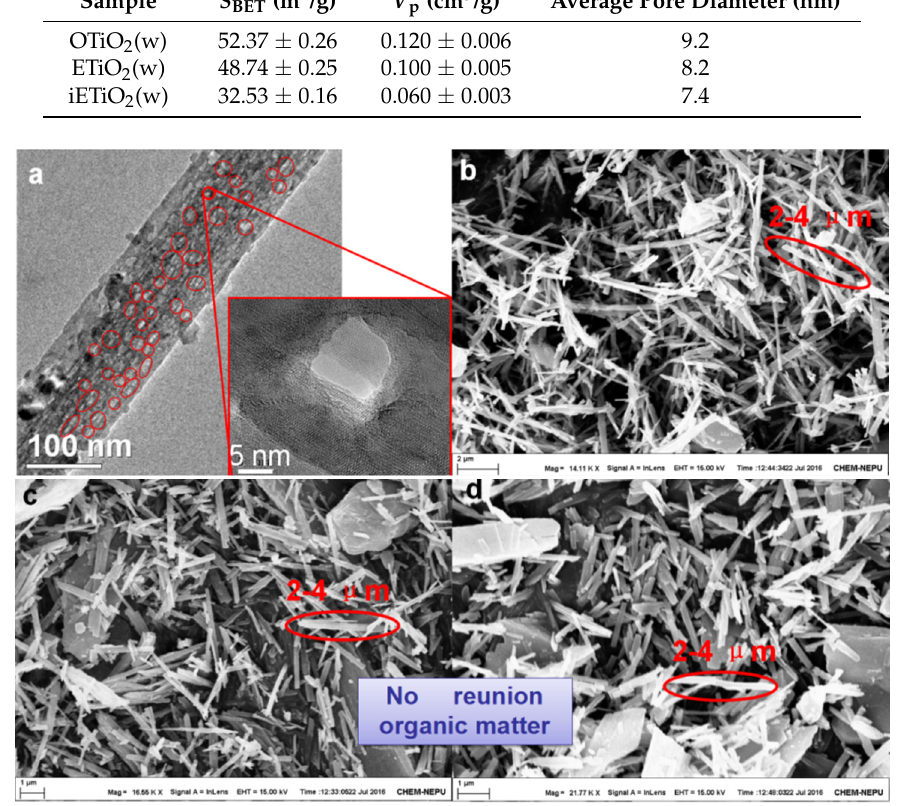
Figure 2. TEM image ( a ) of OTiO 2 (w), SEM images of ( b ) OTiO 2 (w), ( c ) ETiO 2 (w), and ( d ) iETiO 2 (w).